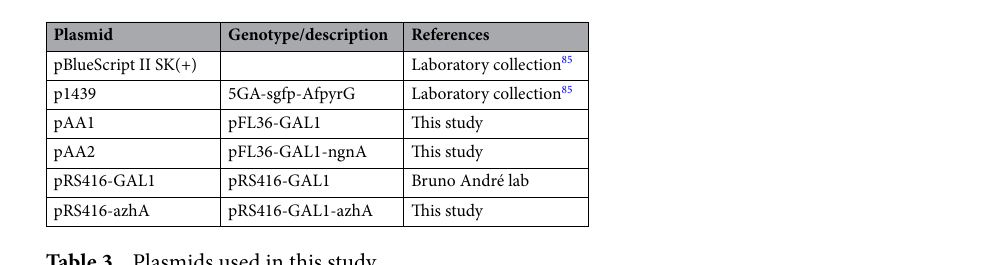
Table 3. Plasmids used in this